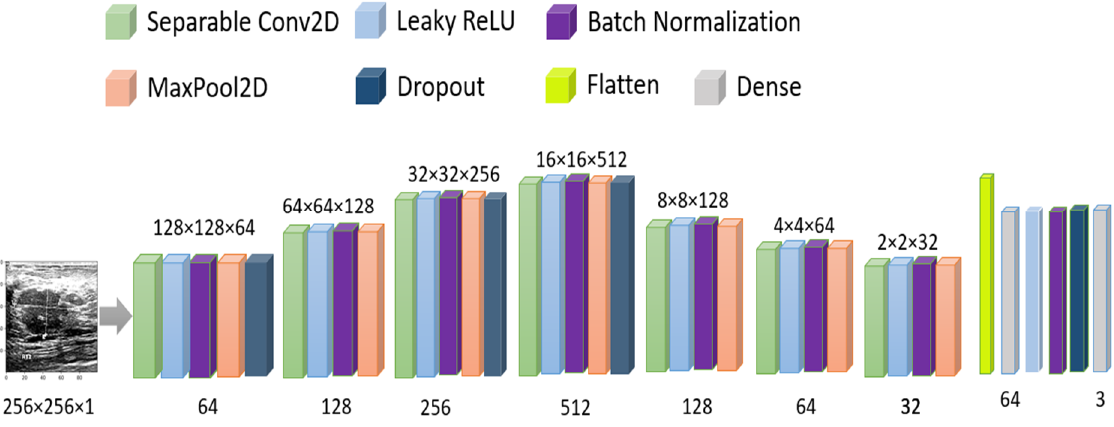
Figure 8. Model architecture for original image training.